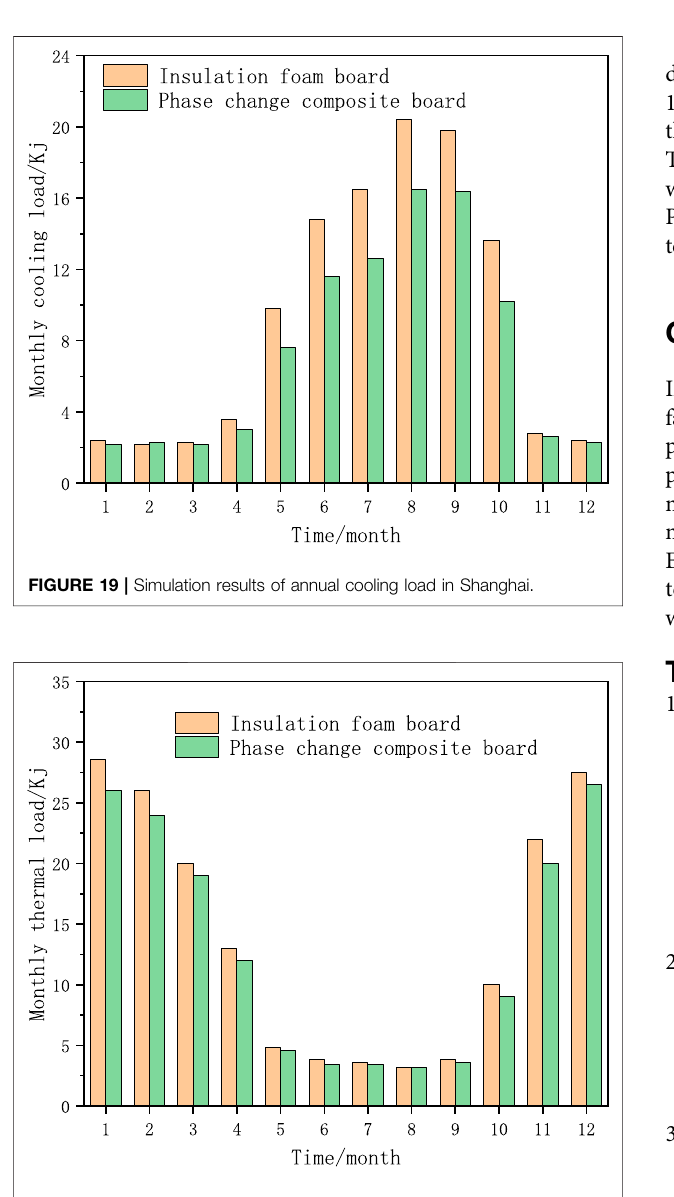
FIGURE 20 | Simulation results of annual heating load in